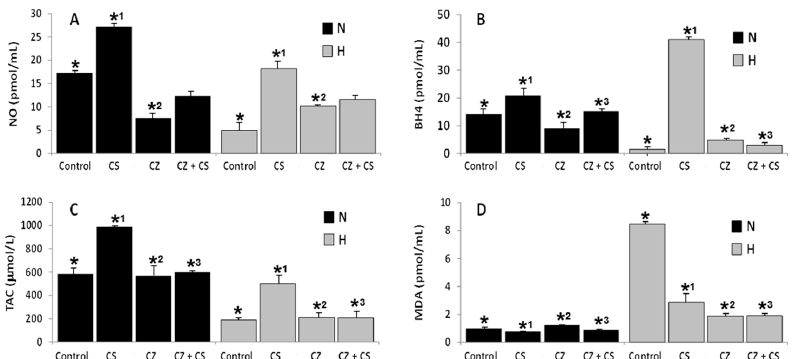
Figure 2. Effects of the capsaicin (CS) and capsazepine (CZ) on levels of nitric oxide (NO) ( A ), tetrahydrobiopterin (BH4) ( B ), total antioxidant capacity (TAC) ( C ), and malondialdehyde (MDA) ( D ), in the sera of normotensive (N) and hypertensive (H) rats. Values represent the mean ± standard deviation of n = 6, (*, * 1 , * 2 , * 3 ) p ≤ 0.05, by Newman’s post hoc test.